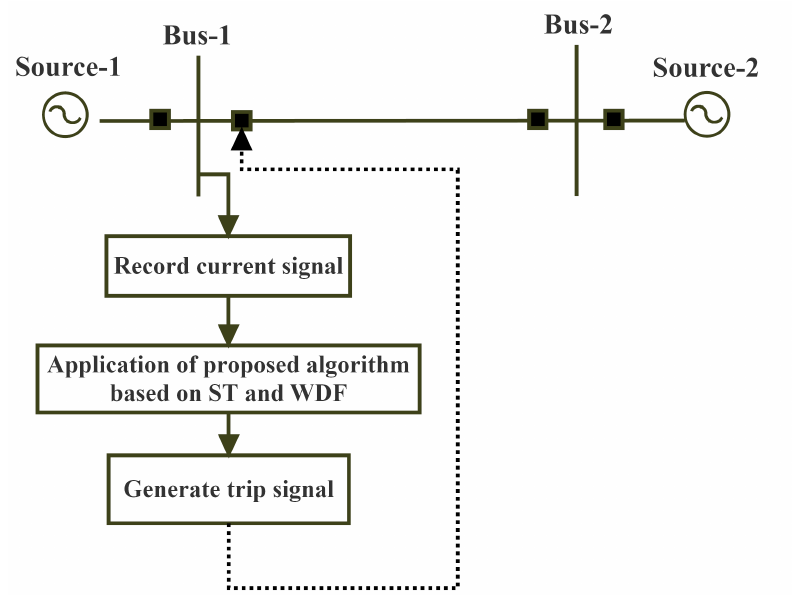
Figure 1. Modified case study system. Table 1. System